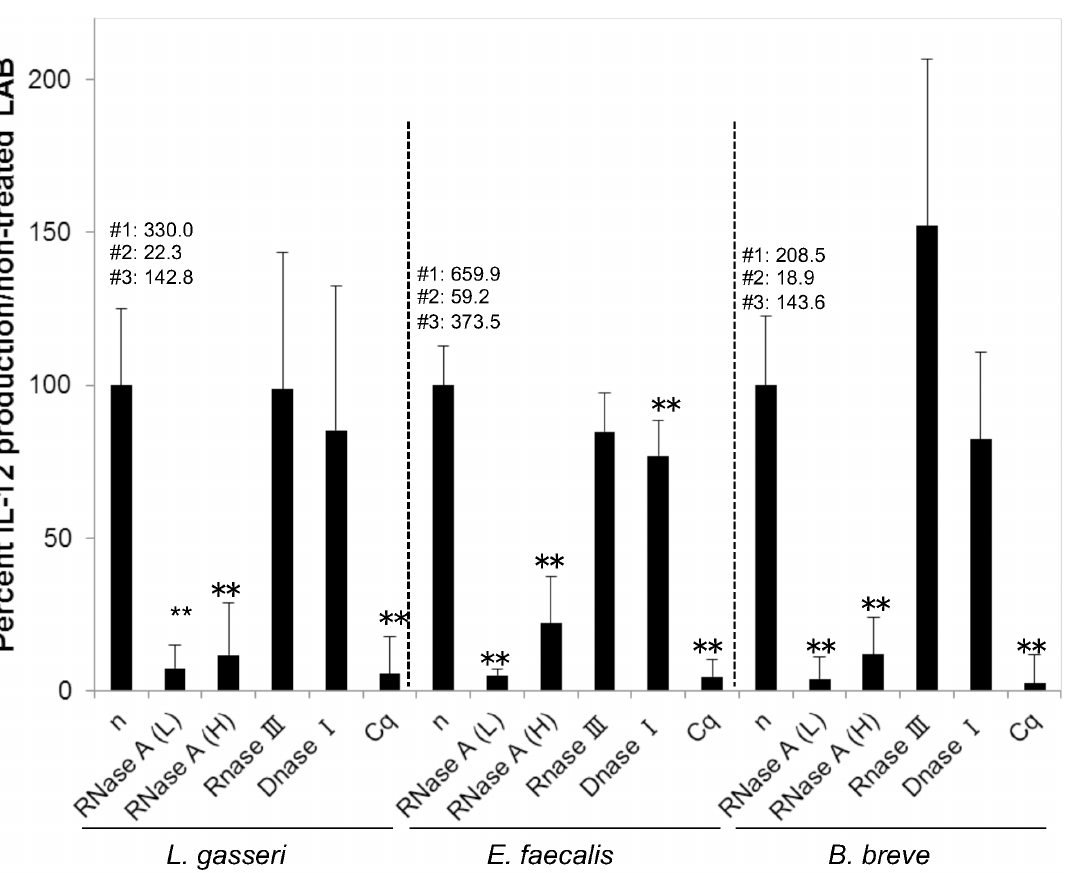
Fig 1. Effect of nuclease treatment of LAB on IL-12-inducing ability in human PBMCs. Heat-killed L . gasseri JCM5344, E . faecalis EC-12, and B . breve JCM1192 were treated with or without nuclease and co-cultured with PBMCs obtained from three donors, for 24 h. The IL-12 protein concentration in the culture supernatant was measured by enzyme-linked immunosorbent assay. Data are expressed as relative percentage to non-treated LAB. The value above the bars of non-treated LAB indicates the mean value of IL-12 concentration (pg/mL) in each donor. n : non-treated, RNase A (L): RNase A treatment in low salt buffer (digests all RNA), RNase A (H): RNase A treatment in high salt buffer (digests ssRNA), Cq : chloroquine treatment of PBMCs prior to bacterial stimulation. ** : P < 0.01 vs non-treated LAB, mean ± SD, n = 3 per donor for each condition.